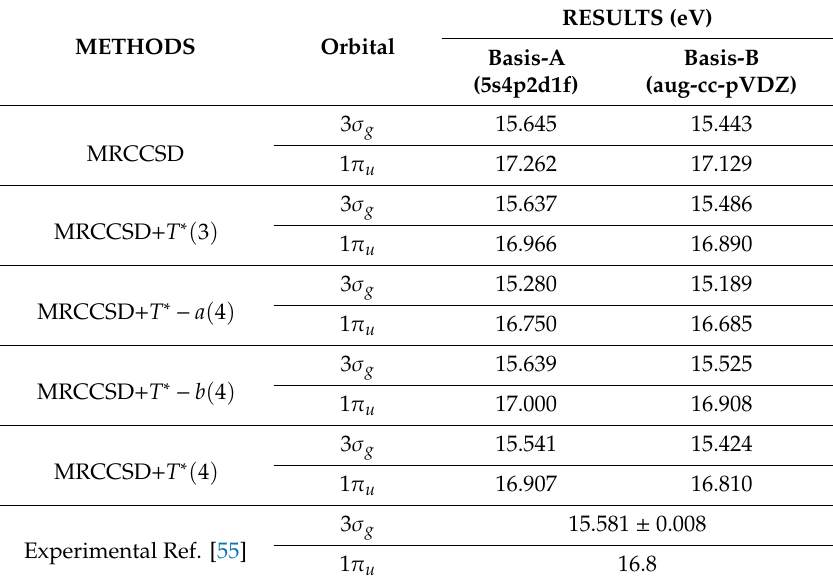
Table 1. Vertical ionization potentials of N 2 using various basis